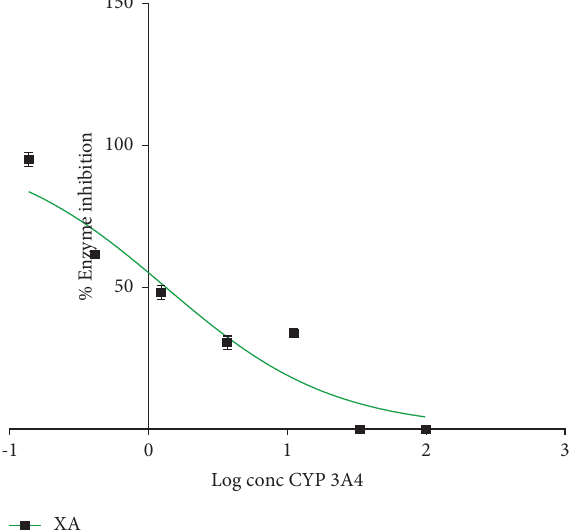
Figure 9: Dose-response curve of varying concentrations of XA against enzyme inhibition on CYP 3A4. XA was added at various concentrations to determine the IC 50 value. Data are presented as mean ± S.E.M. Nonlinear regression analysis was used in plotting the